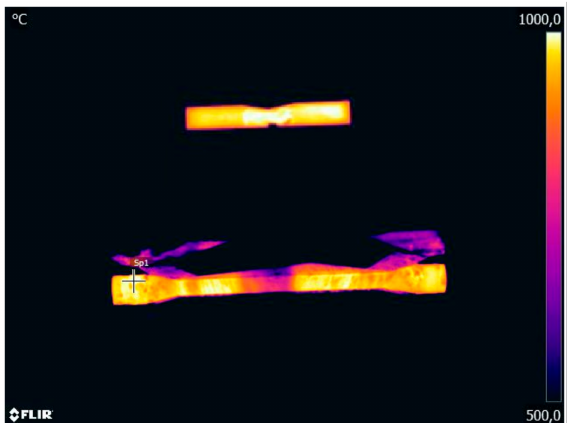
Figure 5. Temperature in the CWR test: (top) billet for rolling, (bottom) workpiece toward the end of the rolling process, conducted with the billet preheated to T 0 = 1000 ◦ C.